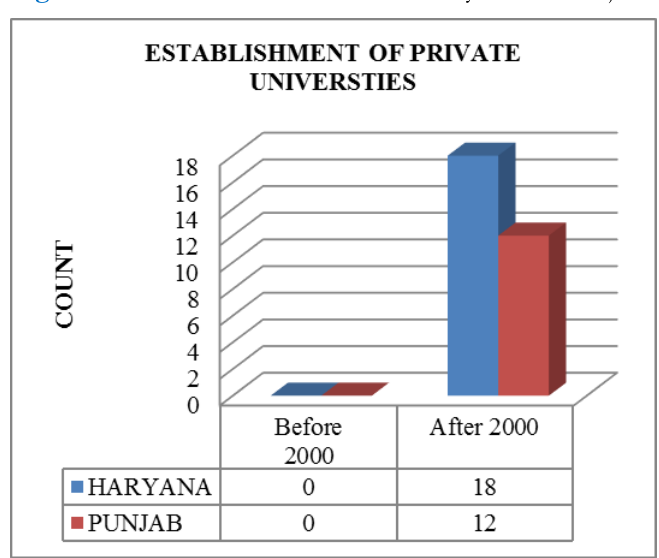
Figure 2. Private Universities in Haryana and